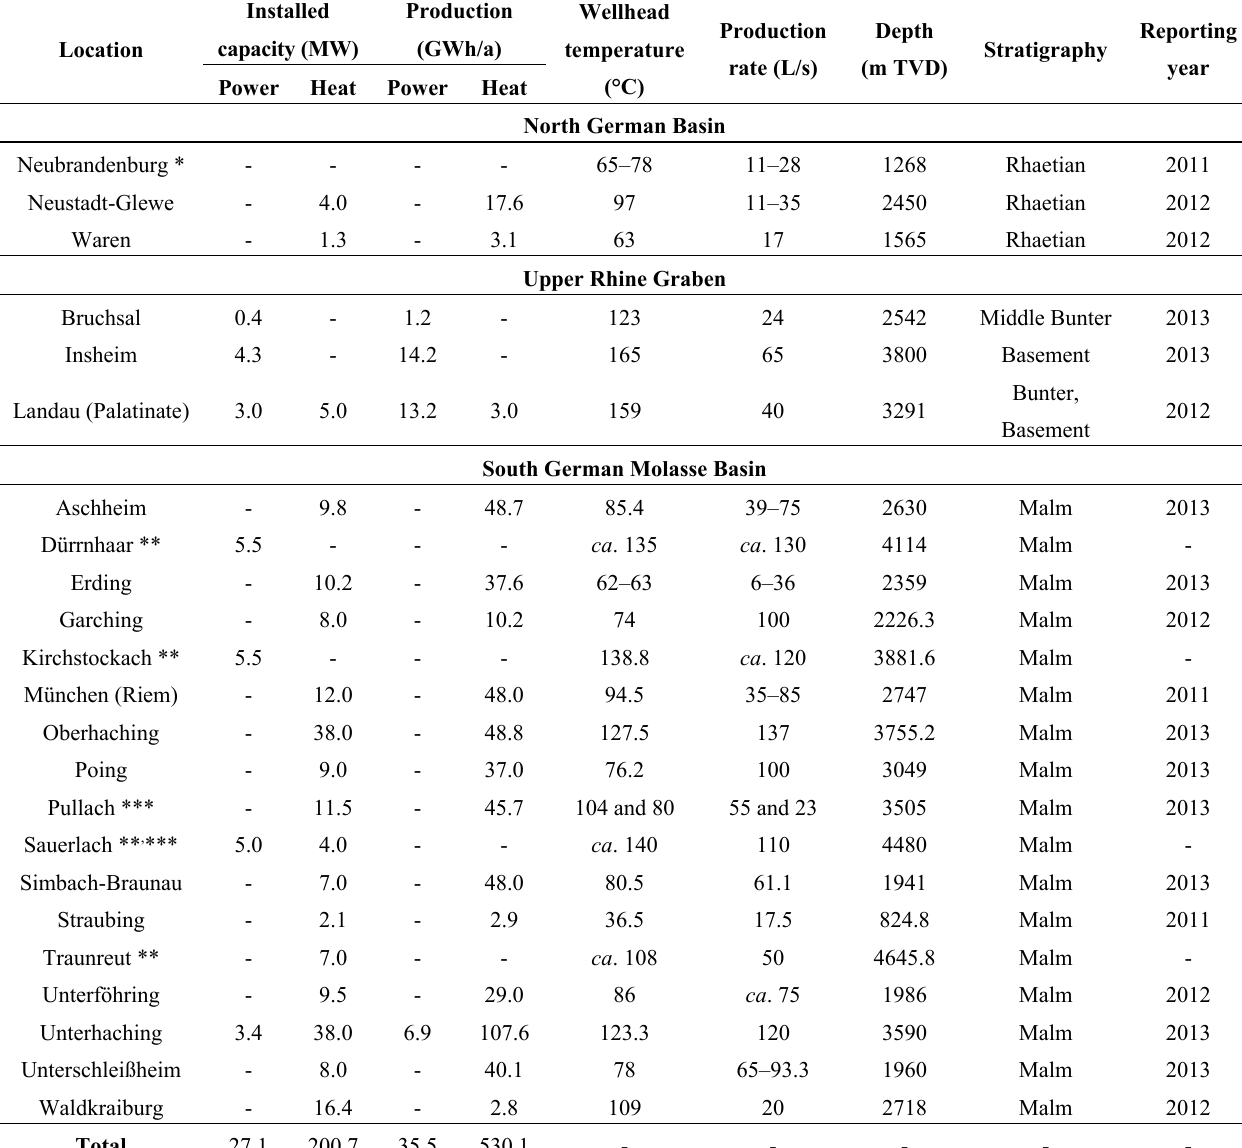
Table 1. Selected operating parameters of major geothermal installations in Germany. TVD: true vertical